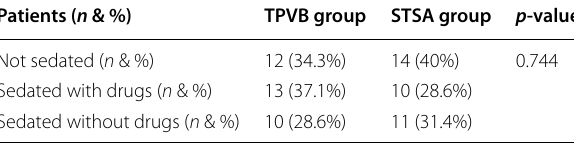
Data are expressed in number and percent ( n